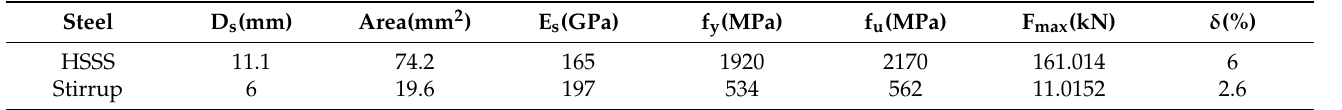
Table 1. Mechanical properties of the steel.